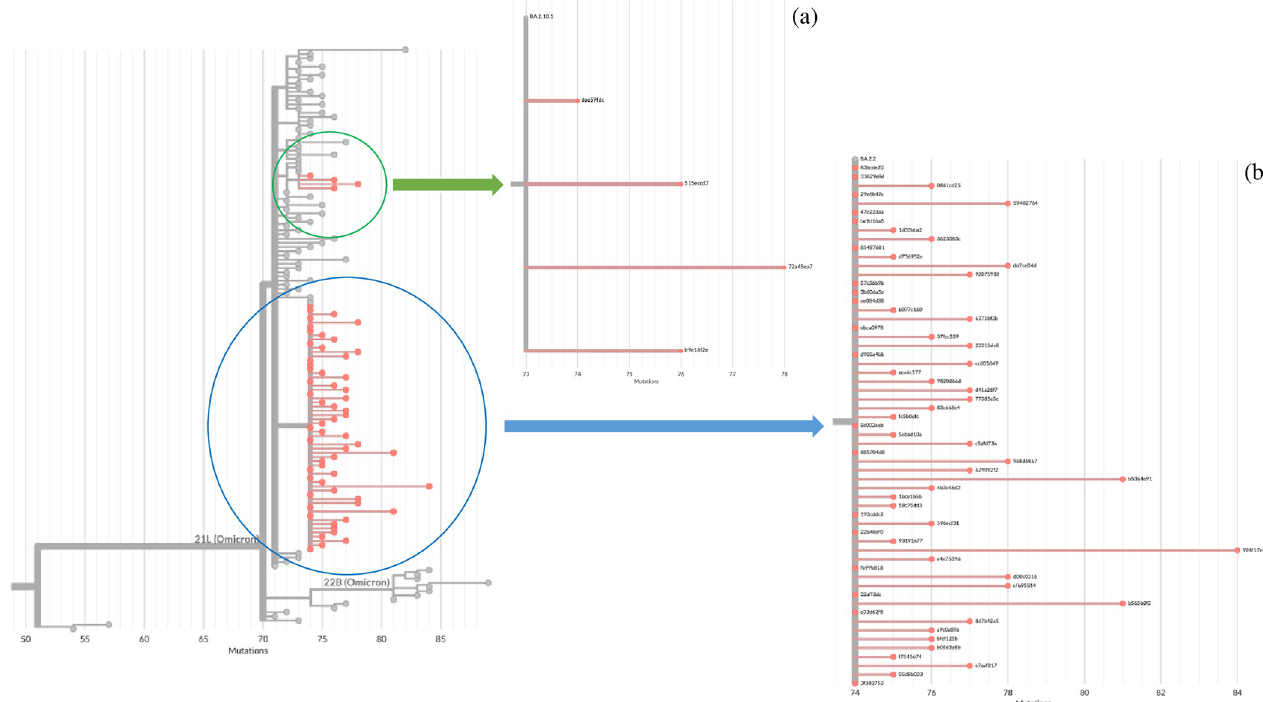
Fig 4. The maximum-likelihood phylogenetic tree of the 65 SARS-CoV-2 genome sequences isolated from pediatric patients between January 2022 and March 2022, during the fifth wave of COVID-19 outbreak in Hong Kong. The phylogenetic tree was rooted on the Wuhan-Hu-1 reference genome sequence and was inferred using IQ-Tree (version 2.1.2) and the GTR+G substitution model and 1000 bootstrap replicates using UFBoot. Tree visualization was generated using FigTree. All of the strains belonged to the PANGO lineage B.1.1.529 (b) and Nextclade clade 21L (a), Omicron variant. Two distinctive groups consisted of a group of 4 genome sequences that belong to subvariant BA.2.10.1 and a second group consisted of 61 genome sequences belonging to subvariant BA.2.2 were